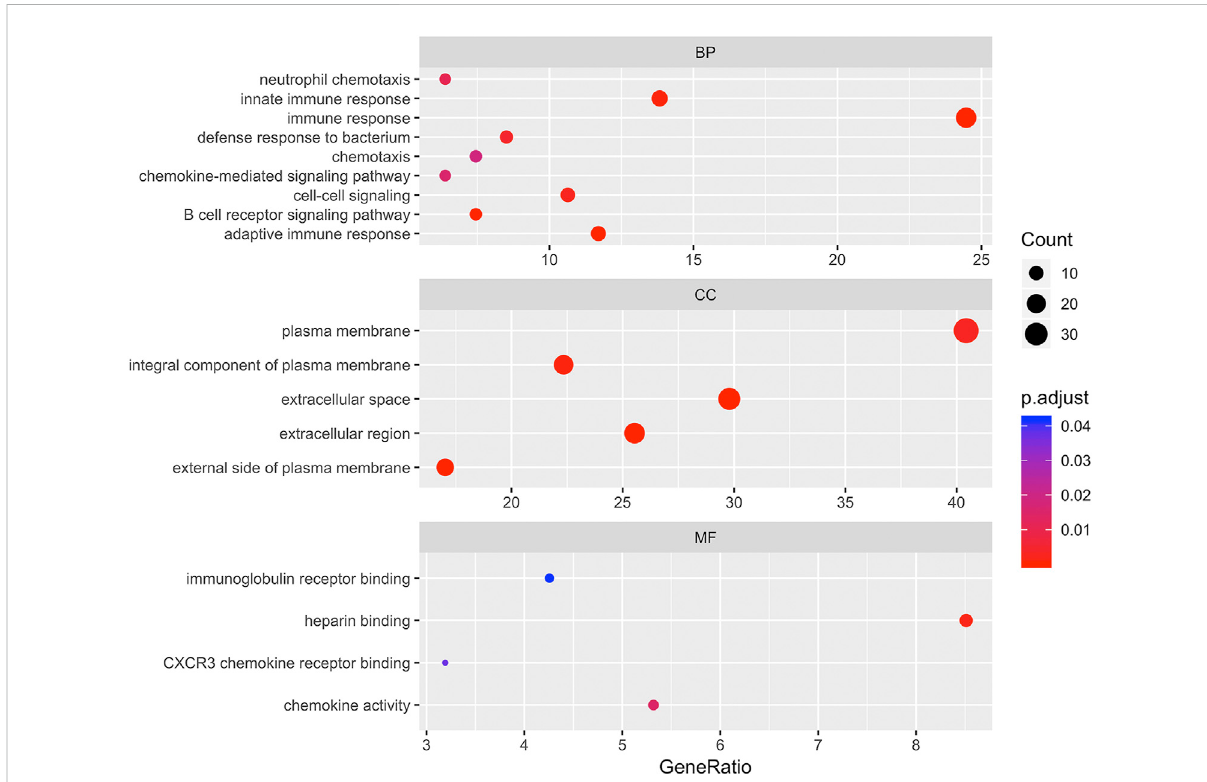
FIGURE 3 Bubbleplotforgeneontology(GO)enrichmentofdifferentiallyexpressedgenes(DEGs).Thex-axislabelrepresentsgeneratiowhiley-axislabel represents GO terms. The size of the dot represents the number of genes in different functional groups, while the color of the dot re fl ects the different p -value range.